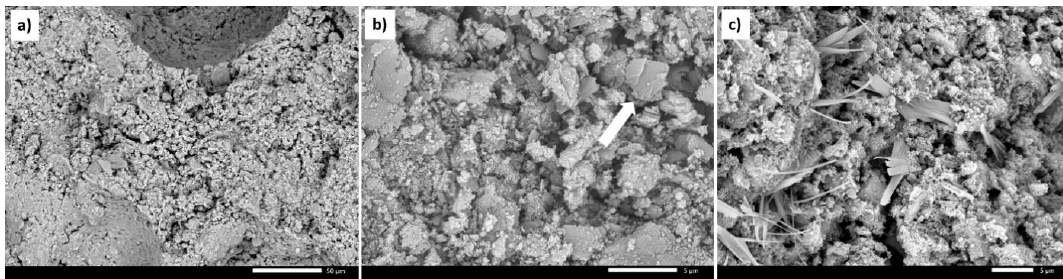
Figure 1. Macroporous structure of zeolite foam AA-S ( a ), crystalline Na/K silicate (white arrow) in AA-S ( b ) and leaves of Na/K silicates in AA-S-Co catalyst ( c ). Table 1. Chemical composition and specific surface area of catalysts and zeolite foam supports.